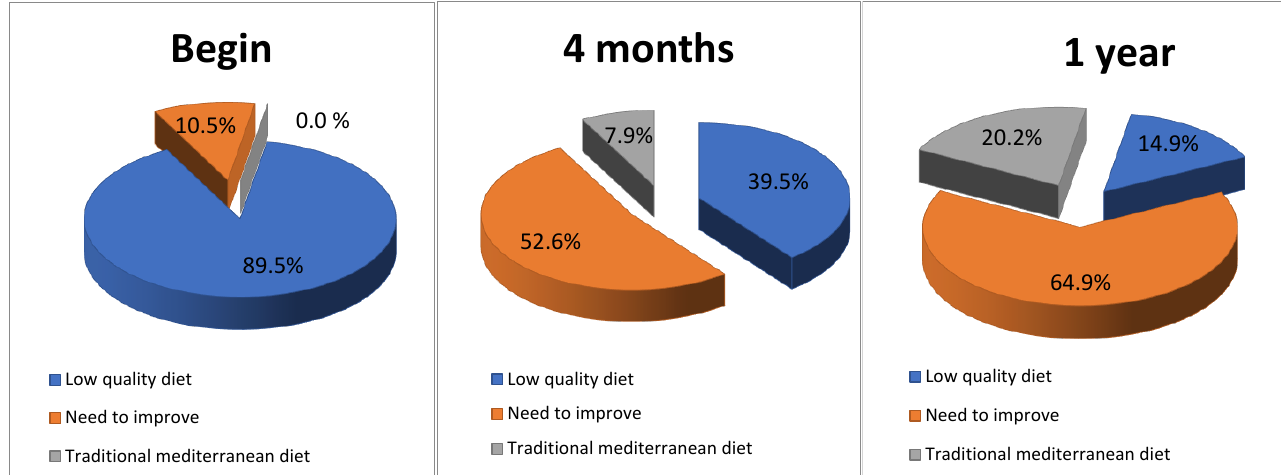
Figure 3. Evolution of diet quality, measured with the TMD Test. In healthy children who accessed the TMD from birth, a low incidence of acute inflammatory diseases and IRD was observed, and this was more notable in those who were breastfed (group 1) compared to those who drank adapted milk (group 2). Compliance with the rest of the TMD parameters was similar in both groups. Both groups evolved satisfactorily with a notable decrease in IRD, in-demand consultations due to illness, and the need to go to the emergency room or require medication treatments. The number of RW attacks or childhood asthma was lower and clinically relevant in group 1, with an incidence of almost half the rate of group 2. The number of drugs used by patients with RW in group 1 was less than half of the number used by patients in group 2 (Table